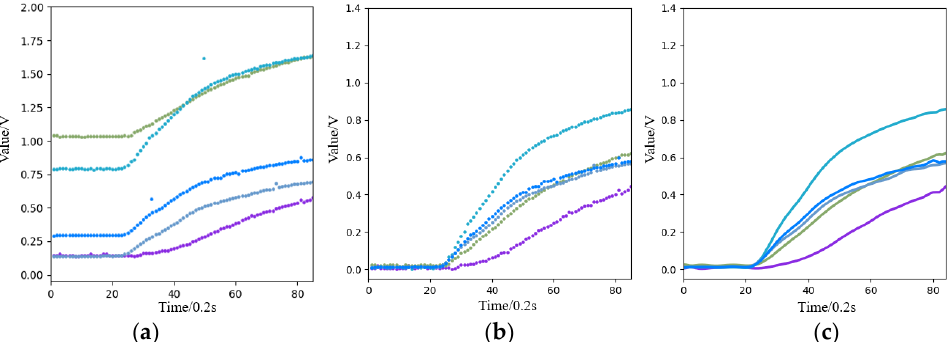
Figure 6. ( a ) Image of the original data; ( b ) Image after baseline processing and removal of abnormal data; ( c ) Image of the fitted curve.